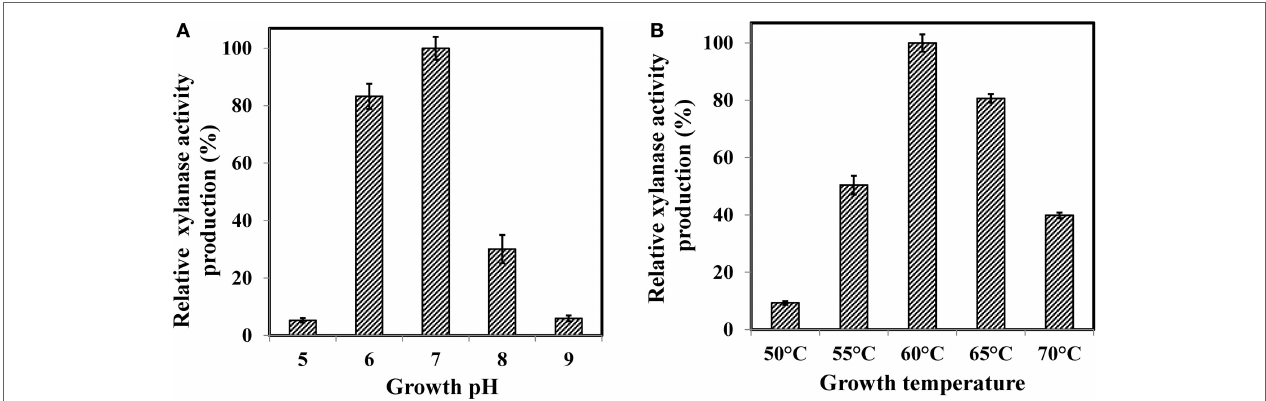
FigUre 1 | effect of (a) growth ph and (B) growth temperature on production of WsUcF1 xylanase . Enzyme production at optimum pH and optimum temperature was defined as 100% (19.3 and 18.7 U/ml, respectively). Values shown were the mean of duplicate experiments, and the variation about the mean was below